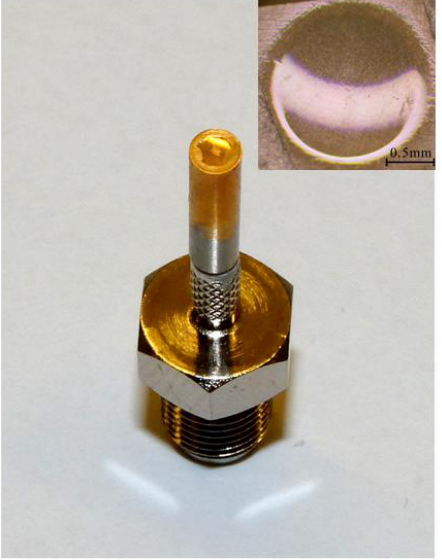
Figure 10. Photographs of the 27 MHz focusing transducer and dimpled element (inset) (with permission from [74]).